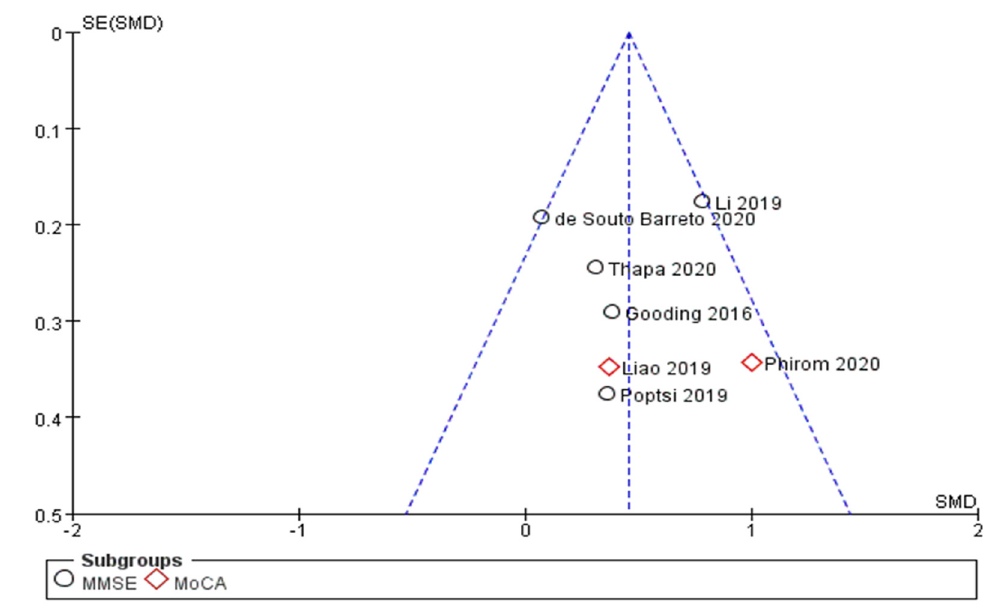
Figure 3. Funnel plot of selected studies.